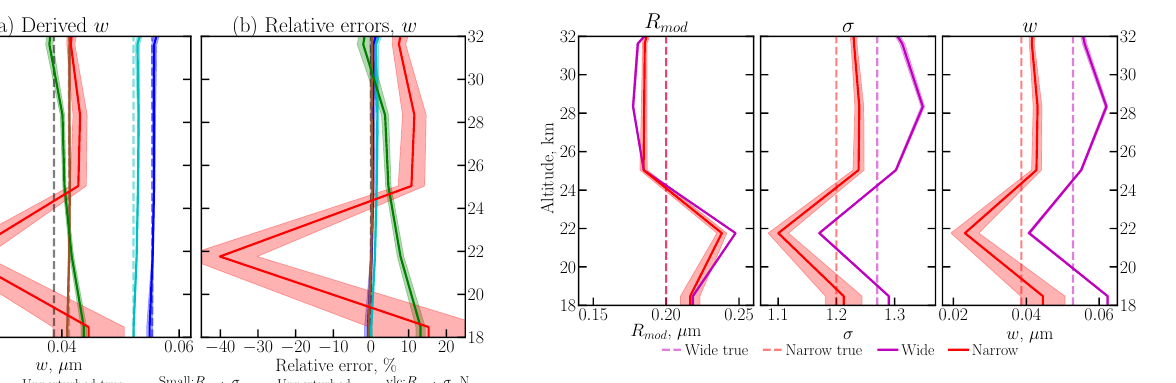
Figure 7. Retrieved profiles (solid lines) of R mod , σ and derived values of w for the volcanic scenarios with perturbed R mod , σ , N for a typical tropical observation geometry. The dashed lines repre- sent the true values. The shaded areas stand for ± 1 standard devia- tion. The scenarios used for the simulations are listed in Table